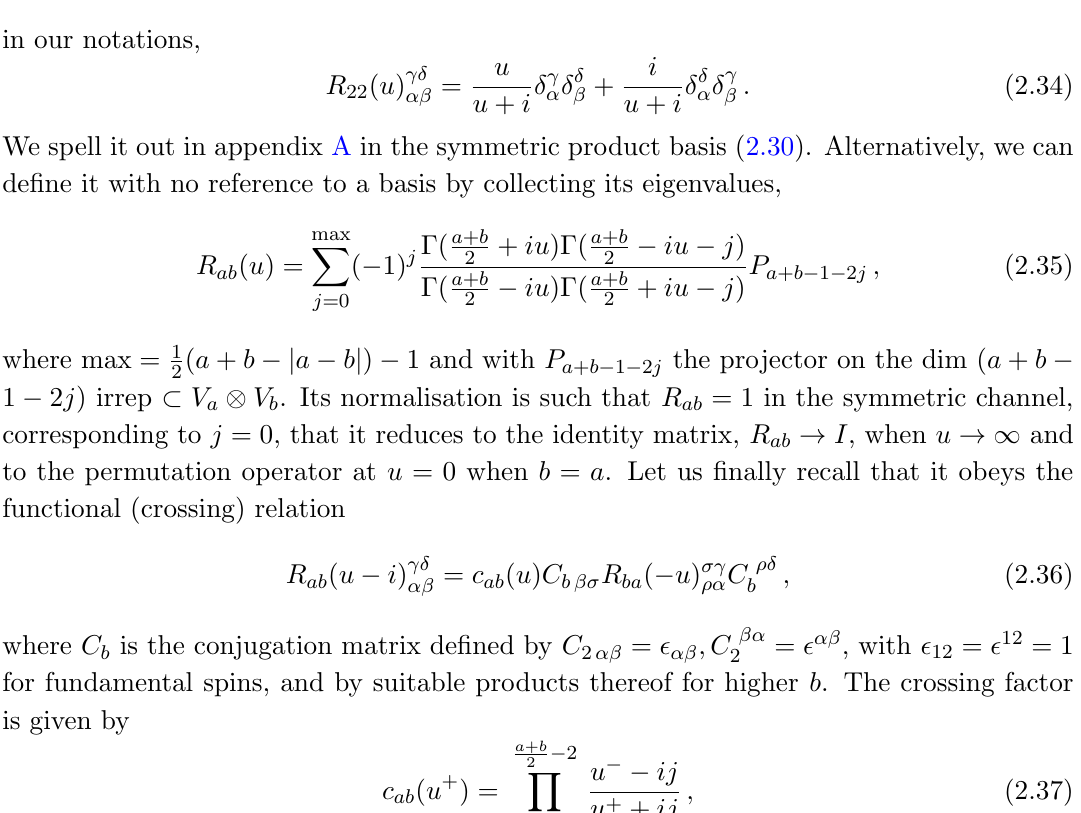
Figure 6 . Hexagon transition H ( u v ) with all magnons going to the left. The numbers of ! incoming and outgoing magnons must match for charge conservation. On the right panel, the SYM domain wall partition functions for the matrix parts when m = 1 and m = 2. At weak coupling the mirror S matrix is transmission-less and the partition function collapses to a single process where the magnons’ (cid:13)avors backscatter one each